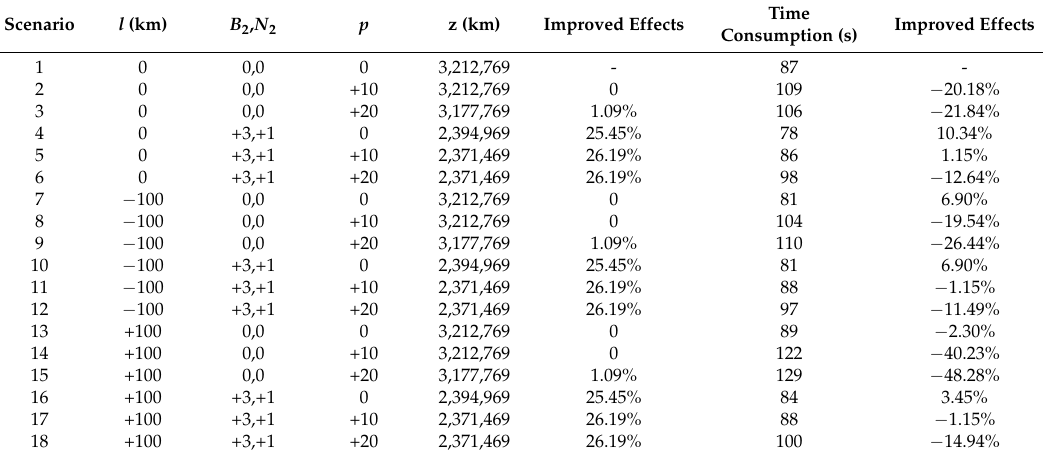
Table 7. Sensitivity analysis comparison